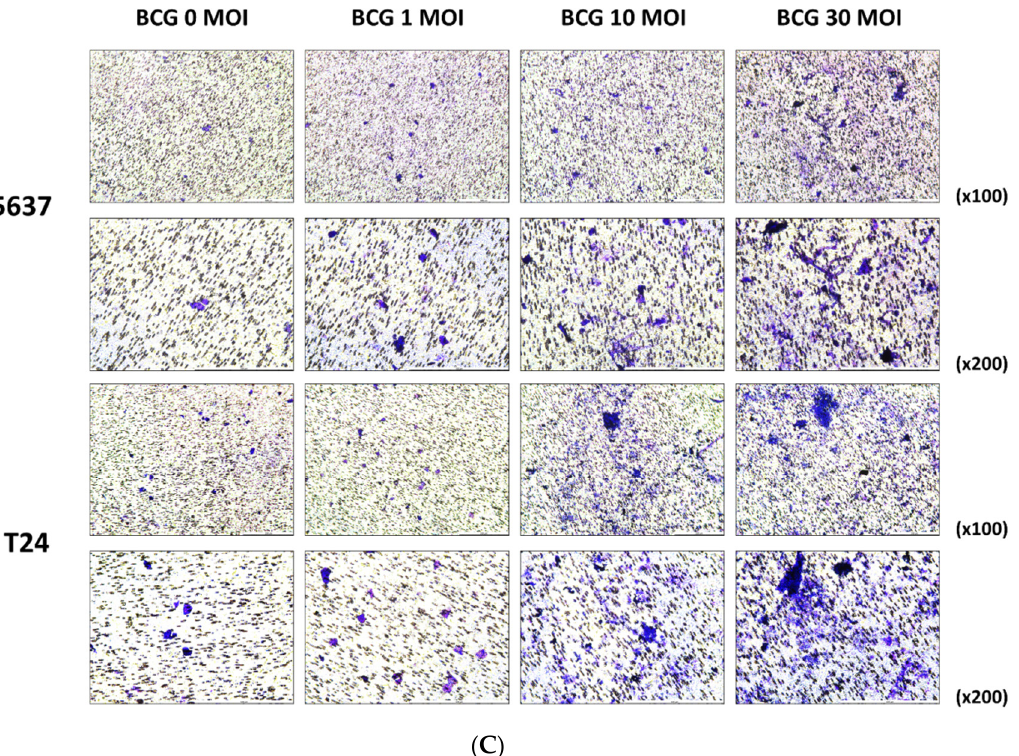
Figure 5. BCG treatment for bladder cancer-on-a-chip. (A ) Bladder cancer cell viability at three days after BCG treatment at bladder cancer on-a-chip. ( B ) concentrations of cytokines (IL-6, IL-12, INF- γ , and TNF- α ) 6 h after BCG treatment at BCOC; ( C ) chemotaxis of monocytic THP-1 cells in permeable membrane 24 h after BCG treatment at BCOC. Data are the mean ± SE of the mean ( n = 3, per group). * p < 0.05, ** p < 0.01. SE: standard error.